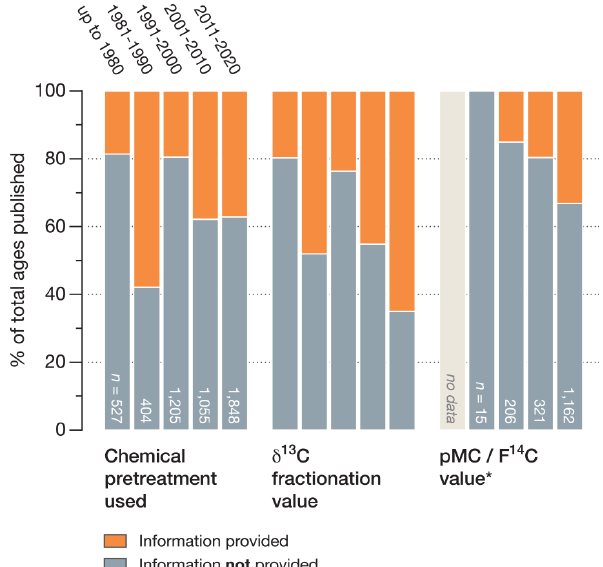
Figure 9. Radiocarbon-dating-related supporting information re- ported in archaeology studies published between 1961 and 2020 and included in the SahulArch Radiocarbon sub-collection. The statis- tics for pMC / F 14 C value only include AMS radiocarbon ages. Note that most studies do not report information on the chemical pretreat- ment method, the δ 13 C fractionation value, or the pMC / F 14 C